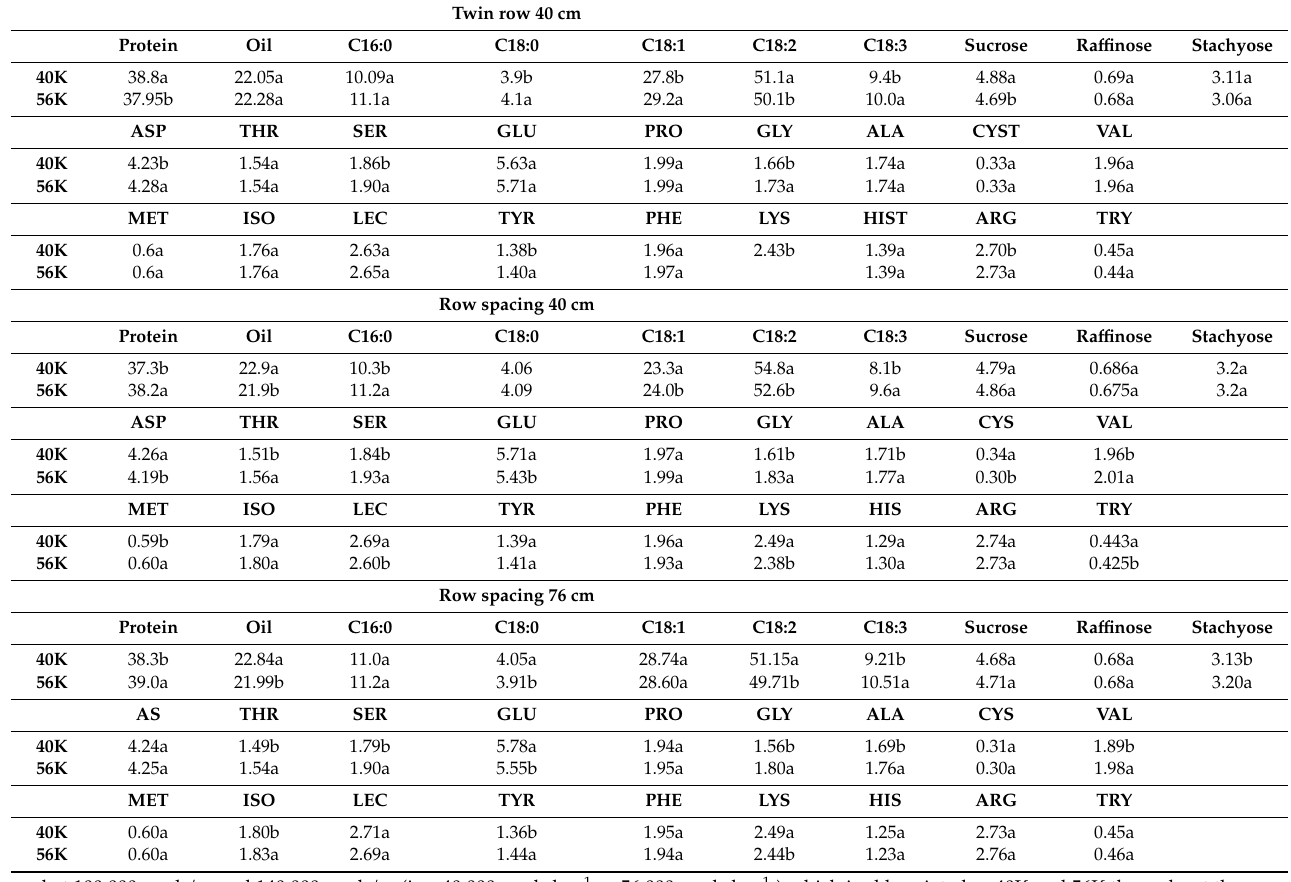
Table 5. The e ff ect of seeding rate a , row spacing (15 inches twin row, 15 row spacing, and 30 row spacing (40 cm and 76 cm, respectively) on seed composition (protein; oil, palmitic (C16:0), stearic (C18:0), oleic (C18:1), linoleic (C18:2), linolenic (C18:3); sugars (sucrose, ra ffi nose, stachyose) (%); and amino acids aspartic acid (ASP), threonine (THR), serine (SER), and glutamic acid (GLU), proline (PRO), glycine (GLY), alanine (ALA), cystine (CYS), valine (VAL), methionine (MET), iso-leucine (ISO), leucine (LEU), tyrosine (TYR), phenylalanine (PHE), lysine (LYC), histidine (HIS), arginine (ARG), and tryptophan (TRY) (%) in cultivar AG 4632 in 2015. Twin row 40